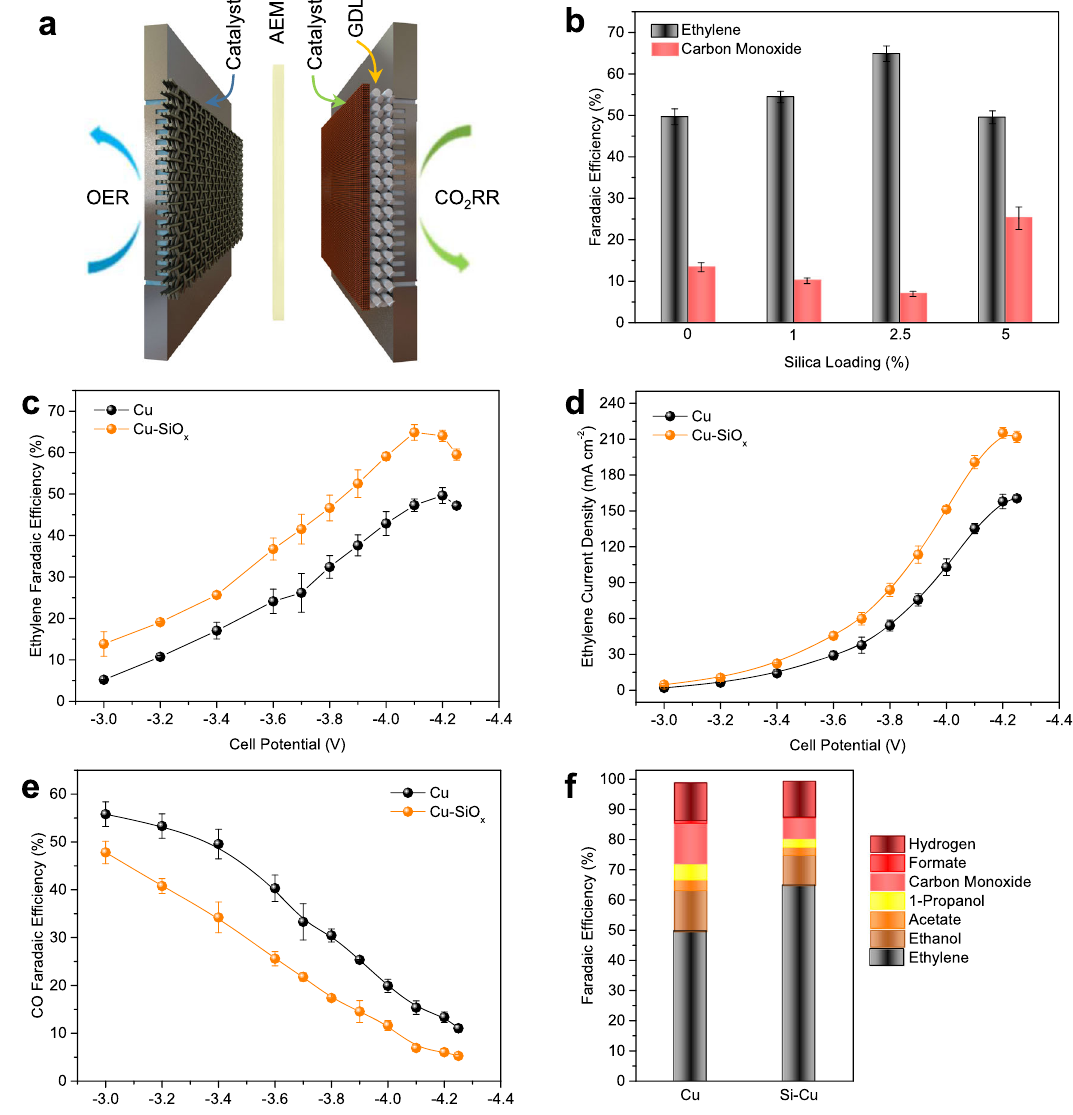
Fig. 3 CO 2 RR performance of different Cu-SiO x catalysts in a MEA electrolyzer with 0.1 M KHCO 3 anolyte. a Schematic illustration of the MEA cell (OER: oxygen evolution reaction, AEM: anion exchange membrane, GDL: gas diffusion layer). b The peak FE ethylene and corresponding FE CO of the bare Cu and various Cu-SiO x catalysts. c – e Comparison of FE ethylene ( c ), ethylene current density ( d ), and FE CO ( e ), respectively, between the 2.5% silica-loaded Cu and bare Cu catalysts. f The peak FE ethylene and related FEs of the other products (i.e., ethanol, acetate, 1-propanol, CO, formate, and hydrogen) of the 2.5% silica-loaded Cu and bare Cu catalysts. Error bars are means± SD ( n = 3